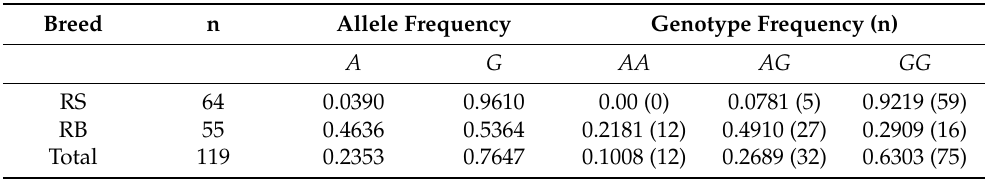
(RS) and Romanian Brown (RB) ca tt le breeds and the entire two-breed population (RS+RB). Breed n Allele Frequency Genotype Frequency (n)